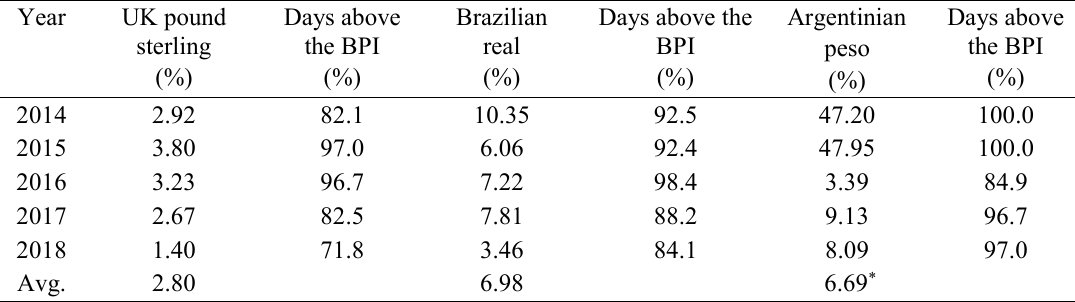
Table 4. Average daily premiums and the percentage of days at which weighted daily prices are above the